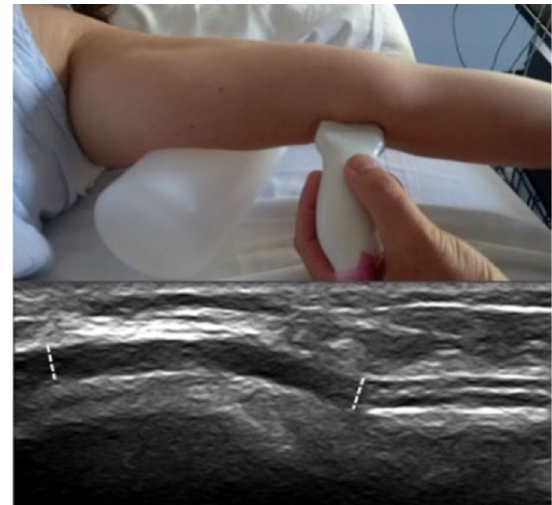
Fig. 1 Top: position of the arm for the longitudinal ultrasound examination. Bottom: normal ultrasound of the UN at the elbow in the longitudinal evaluation; white lines indicate ASD, distal (right) and proximal